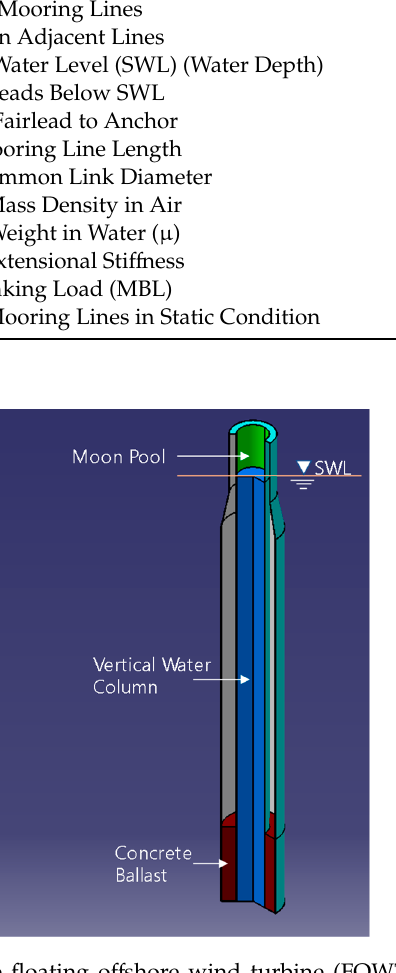
Figure 2. Overview of spar-type FOWT and global coordinate system. Note: ML = Mooring line. 3. Design Process For the design optimization of a floating offshore wind turbine, the design process is made up of three steps, as shown in Figure 3. The first step is hydrostatic optimization. The basic platform geometrics and mass distribution are estimated based on the constraint conditions and with the objective of reducing the structure mass and platform volume displacement. The second step analyzes the hydrodynamic responses of the platform models which were selected from step 1.